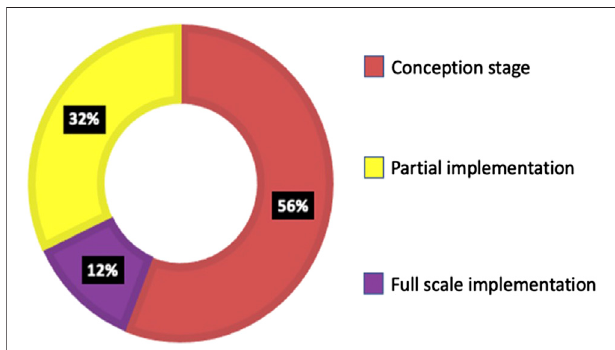
FIGURE 5 | Percentage of states implementing E-ticketing at various